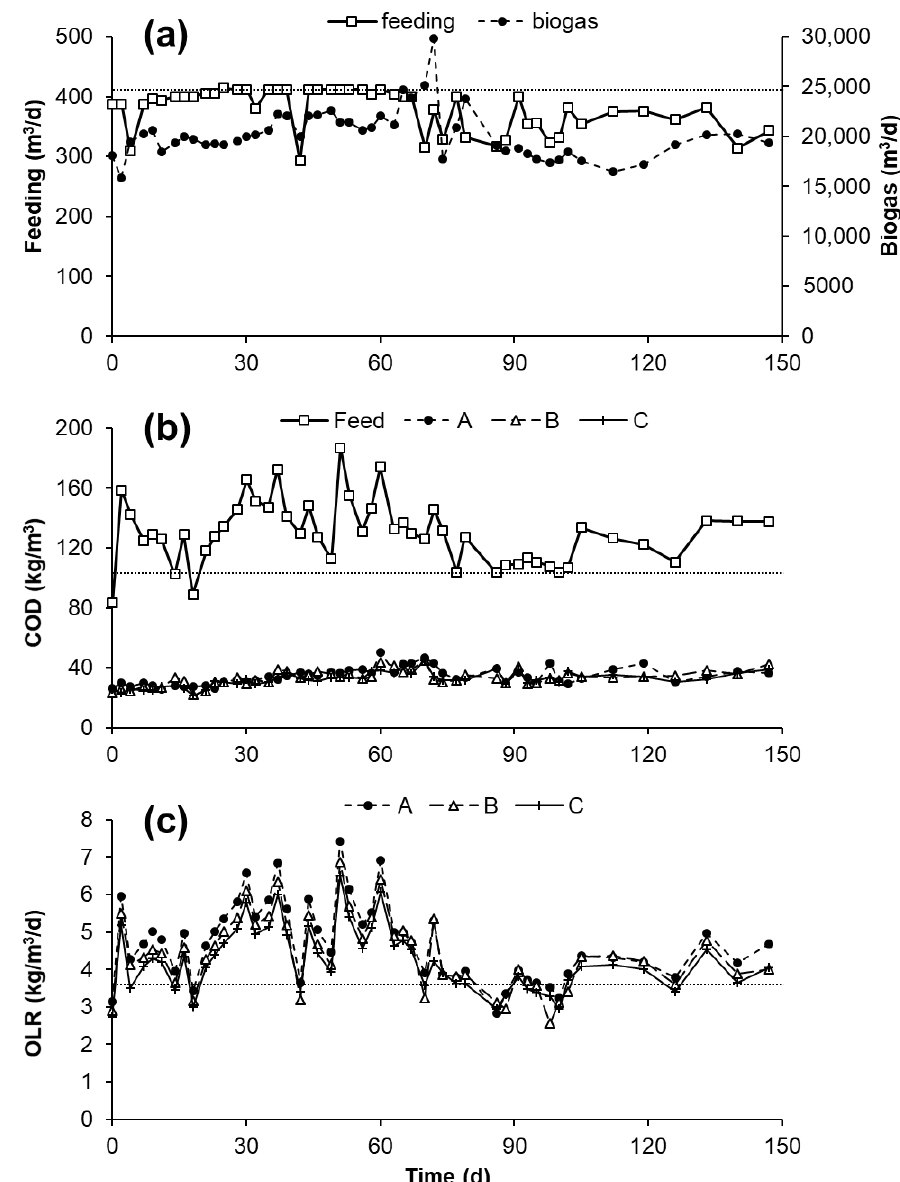
Figure 2. Profiles of selected operational parameters for the full-scale digesters: ( a ) daily feeding and biogas production, ( b ) chemical oxygen demand (COD), and ( c ) organic loading rate (OLR). Dotted lines represent design values for daily feeding, input COD, and OLR.